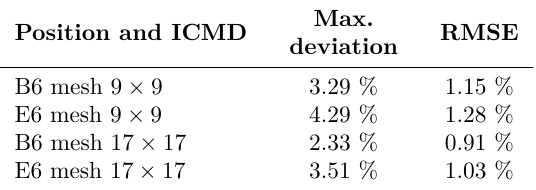
Table 2. Max. relative differences of RBF-based power reconstruction from reference data.